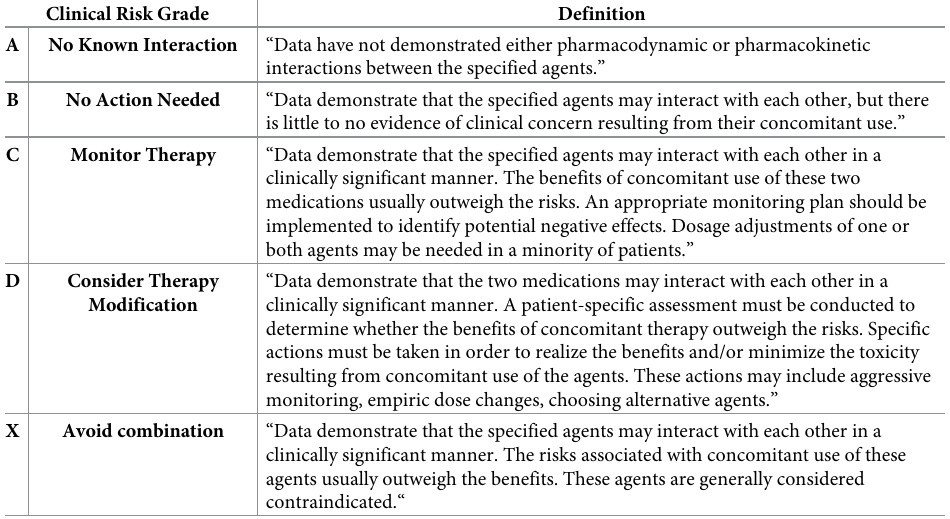
Table 3. Grouping of interactions from a clinical risk perspective based on UptoDate Lexicomp 1 interaction database